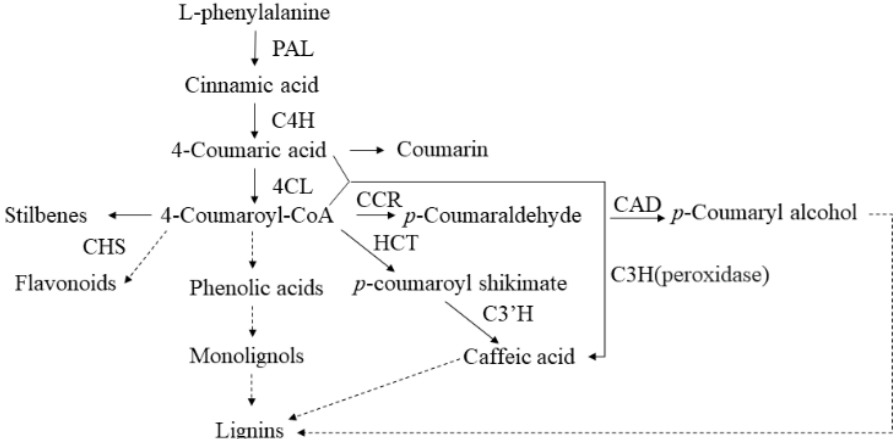
Figure 7. A part scheme of phenylpropanoid metabolism. 4CL, 4-coumarate-CoA ligase; C3H, coumarate 3-hydroxylase; C3 ′ H, p-coumaroyl shikimate 3 ′ hydroxylase; C4H, cinnamic acid 4-hydroxylase; CAD, cinnamyl alcohol dehydrogenase; HCT, Hydroxycinnamoyl-CoA shikimate/quinate hydroxycinnamoyl transferase; CCR, cinnamoyl-CoA reductase; CHS, chalcone synthase; PAL, phenylalanine ammonia-lyase.